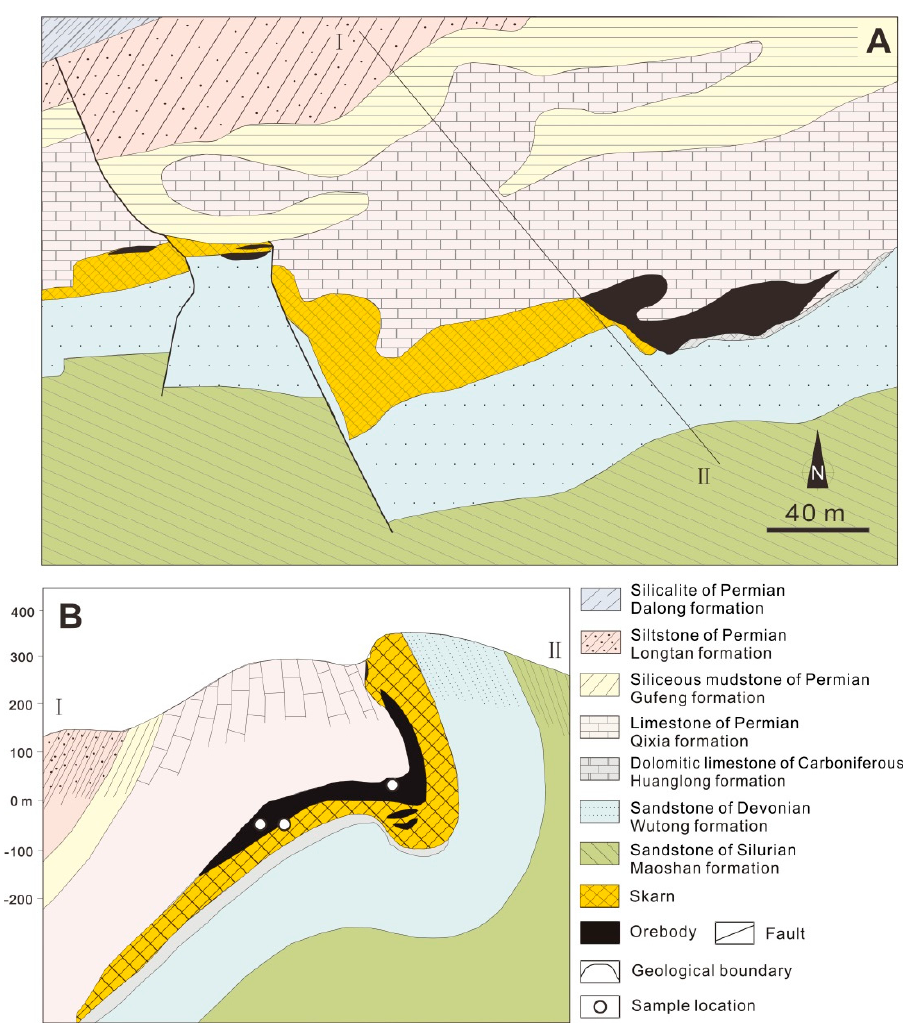
Figure 2. ( A ) Geological map of the Taochong iron deposit (modified from [33]). ( B ) Cross section of the Taochong iron deposit showing the shape of orebodies and their relationship to host rocks (modified from [34]).